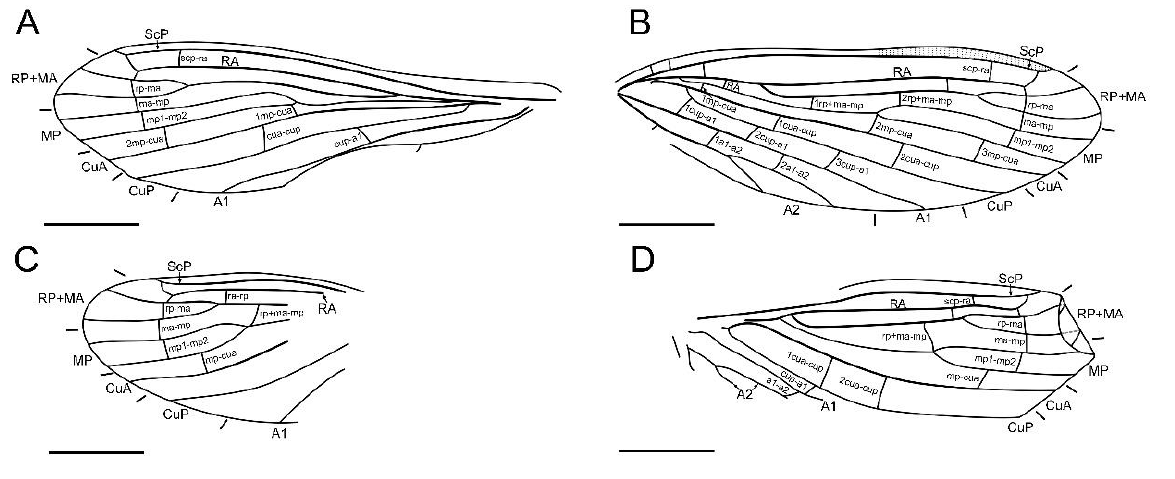
Figure 6. Paradoxoconis longipalpa gen. et sp. nov. , holotype: BXAM BA-NEU-010, drawings of wing venation. ( A ) Right forewing; ( B ) left forewing; ( C ) right hind wing; ( D ) left hind wing. Scale bar = 1.0 mm.